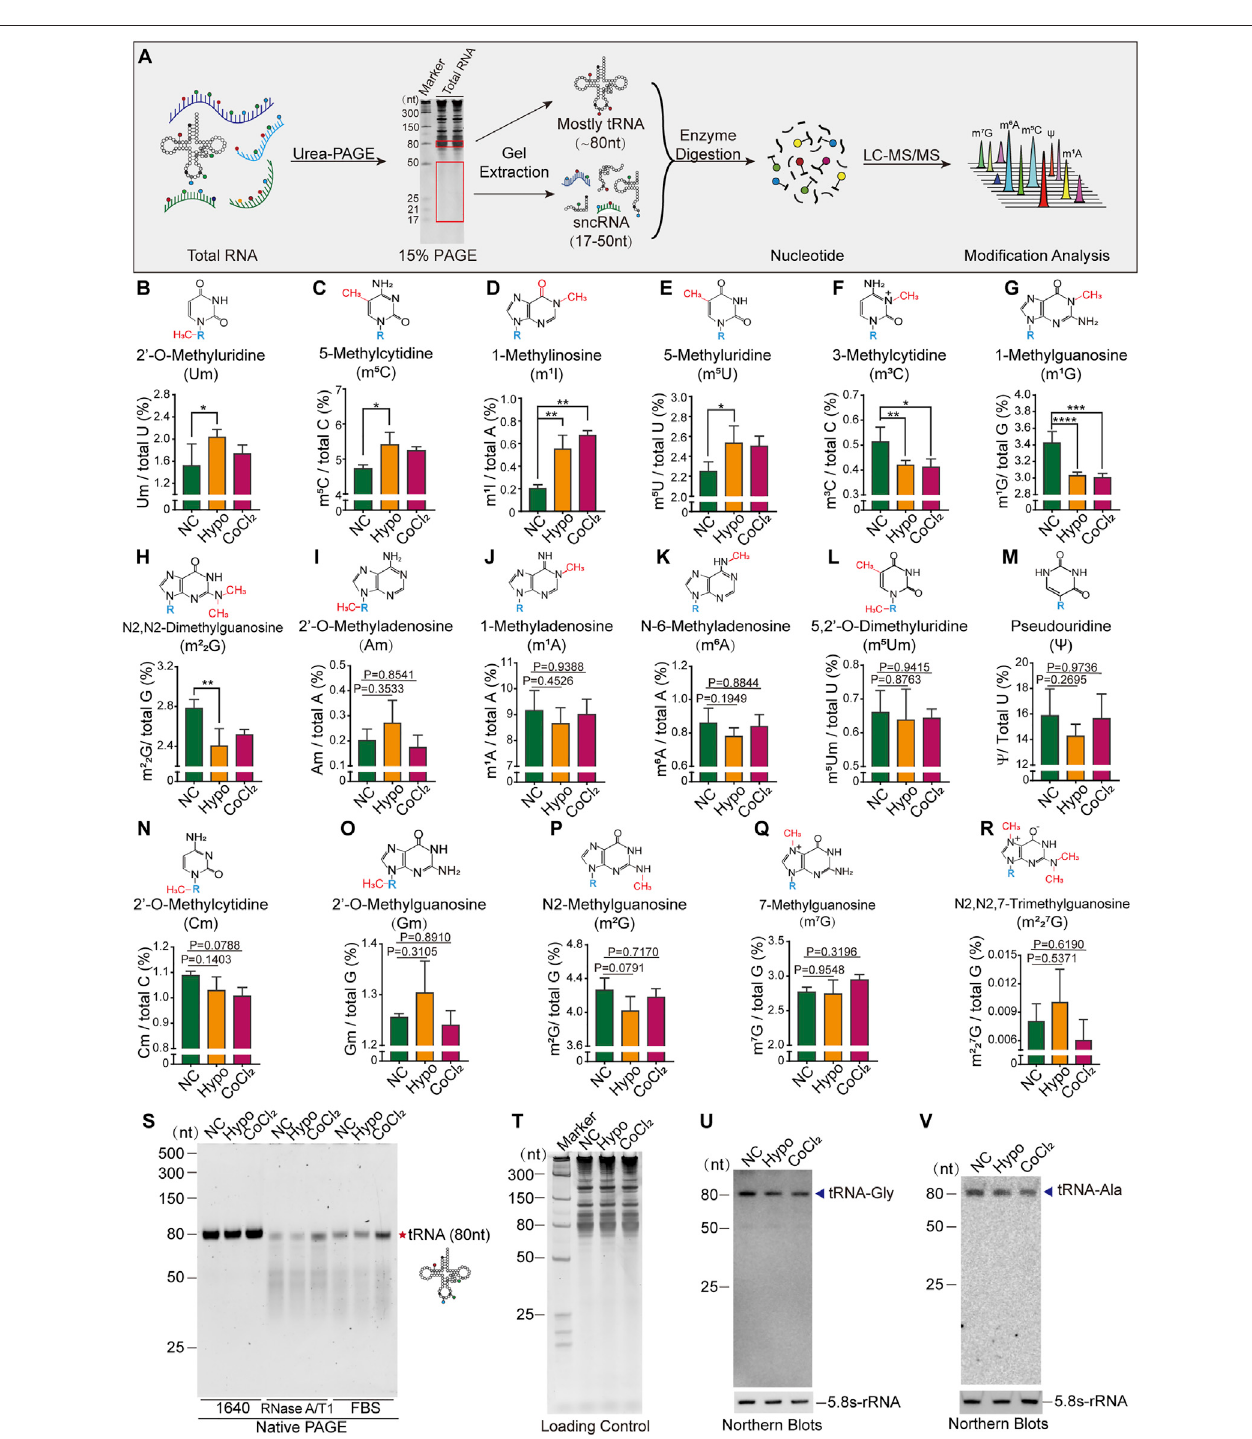
FIGURE 2 | Cellular hypoxia treatment induced alterations in tRNA modi fi cation levels and tRNA stability in GC-2spd cells. (A) Illustration of the detection of RNA modi fi cationsinGC-2spdcellsbyLC-MS/MS. (B – R) RelativelevelsofUm,m 5 C,m 1 I,m 5 U,m 3 C,m 1 G,m 2 2 G,Am,m 1 A,m 6 A,m 5 Um, ψ ,Cm,Gm,m 2 G,m 7 G,andm 2 27 G in 80 nt-sized RNA fragments (mostly tRNA) in GC-2spd cells subjected to hypoxic conditions for 48 h or treated with 150 μ M CoCl 2 for 24 h. (S) Alterations in tRNA stability in GC-2spd cells subjected to hypoxic stress. Using a native PAGE gel, it was shown that the resilience of tRNA to degradation by RNase in the hypoxia- and CoCl 2 -treated groups was signi fi cantly different from that in the normoxia group, as determined using RNase A/T1 and 0.8% FBS (fetal bovine serum containing a unique combination of RNases). Each panel is presented as a representation of three independent experiments with similar results. (T – V) Representative tRNA